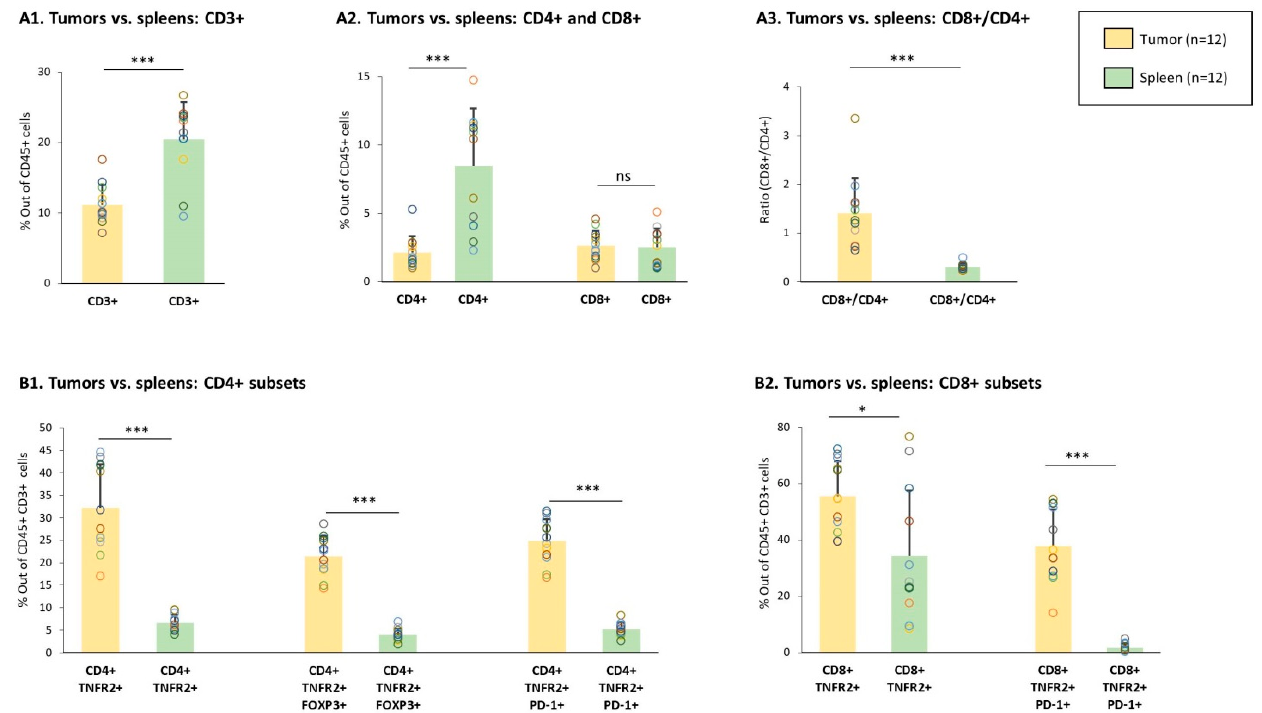
Figure 2. Proportions of lymphocyte sub-populations in TILs and spleens of vehicle-treated tumor-bearing mice. Murine 4T1 TNBC cells were syngrafted to the mammary fat pads of female BALB/c mice. The Figure demonstrates data of TILs and splenocytes from vehicle-treated tumor-bearing mice; n = 12 in total, in 3 biological repeats. ( A ) Proportions of CD3+, CD4+, and CD8+ populations, gated out of CD45+ cells. ( A1 ) Percentage of CD3+ cells. ( A2 ) Percentages of CD4+ and CD8+ cells. ( A3 ) Ratio of CD8+ cells over CD4+ cells, calculated on the basis of the percentages of the two subsets in each mouse. ( B ) Proportions of CD4+ and CD8+ subsets. ( B1 ) CD4+ TNFR2+, CD4+ TNFR2+ FOXP3+, and CD4+ TNFR2+ PD-1+ cells, gated out of CD45+ CD3+ cells. ( B2 ) CD8+ TNFR2+ and CD8+ TNFR2+ PD-1+ subsets, gated out of CD45+ CD3+ cells. Gating procedures are described in Figures S1 and S2 and in “Section 2”. Data are presented as average ± SD of percentages of the specific subset, in all mice belonging to each group. The data of each mouse are presented as a dot. *** p < 0.001, * p < 0.05 (two-tailed unpaired Student’s t -test).